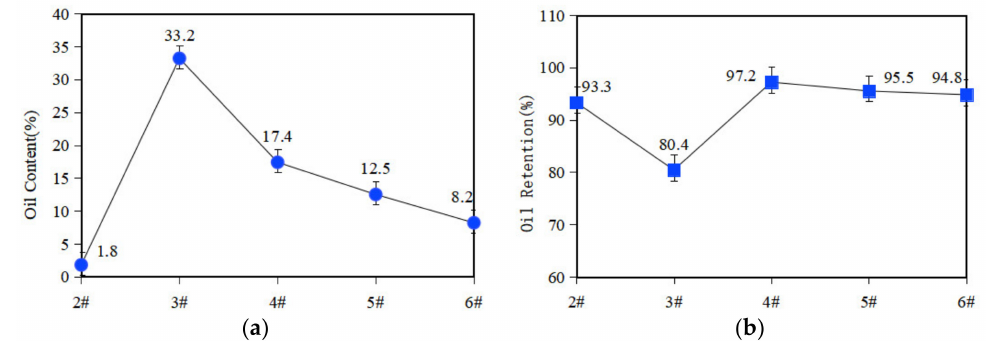
Figure 5. Oil content and oil retention of porous samples. ( a ) Oil content of 2#~6# samples; ( b ) Oil retention of 2#~6#